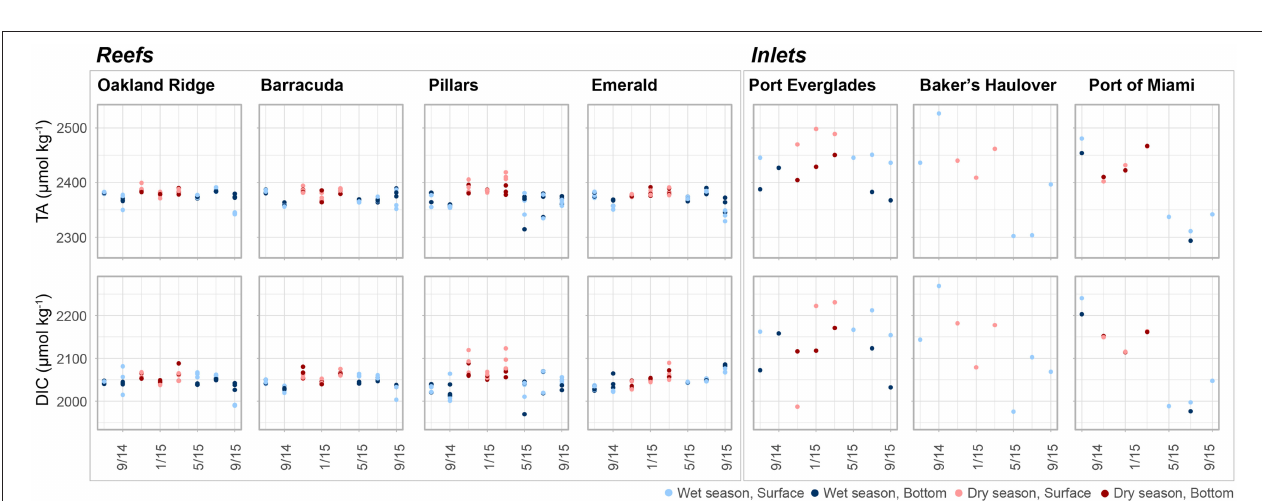
FIGURE 3 | Total alkalinity (TA, µ mol kg − 1 ) and dissolved inorganic carbon (DIC, µ mol kg − 1 ) at each of four reef and three inlet sampling sites. Data are divided into dry (red) and wet season (blue). Darker colors represent samples taken above the benthos while lighter colors represent samples taken at the surface. P values are given for significant differences as determined by ANOVA (A) or nonparametric Kruskal-Wallis (KW) tests. Non-significant ( p > 0.05) are marked ns. An outlier surface sample (2,716.5, 2,557.8 µ mol kg − 1, TA and DIC, respectively) from Port Everglades collected in September 2014 is not shown in order to be better visualize the dataset.